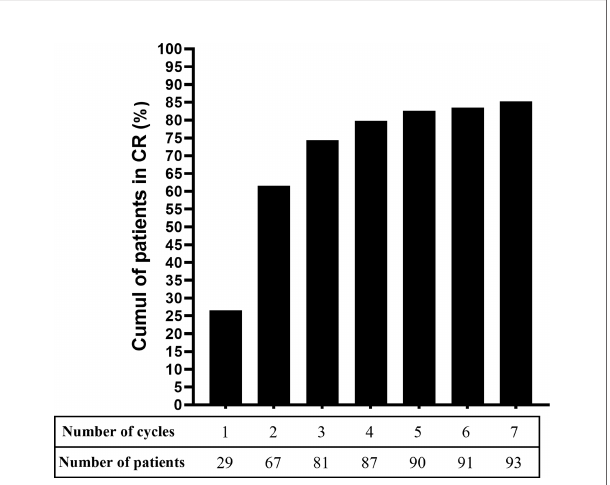
FIGURE 3 | Cumulative proportion of patients with mucous membrane pemphigoid that achieved complete remission with